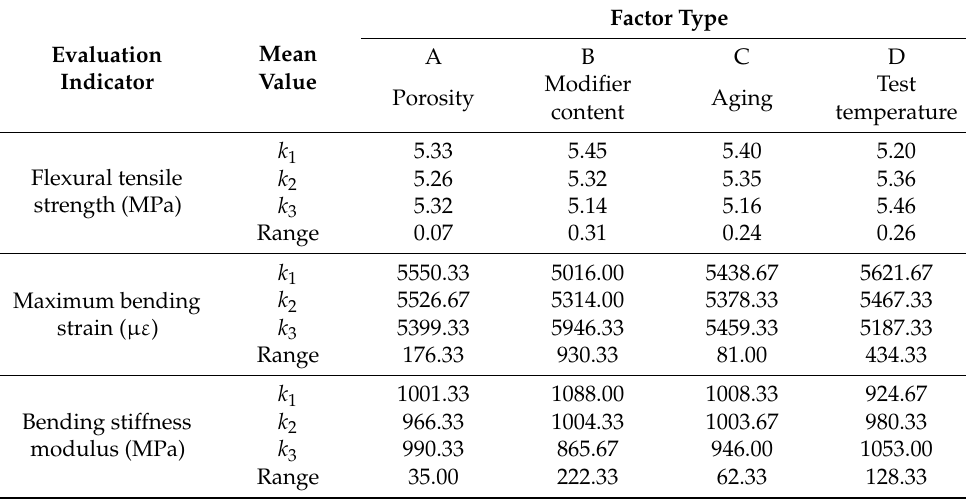
Table 15. Range analysis of results of low temperature bending